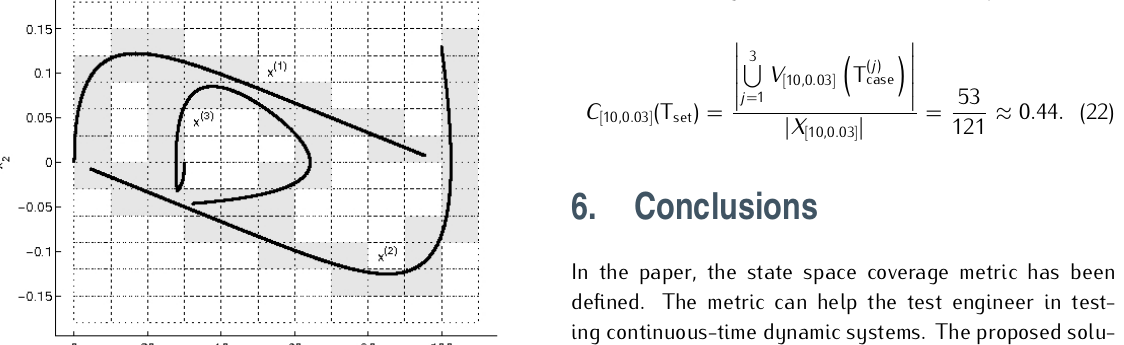
(gray rectangles) set